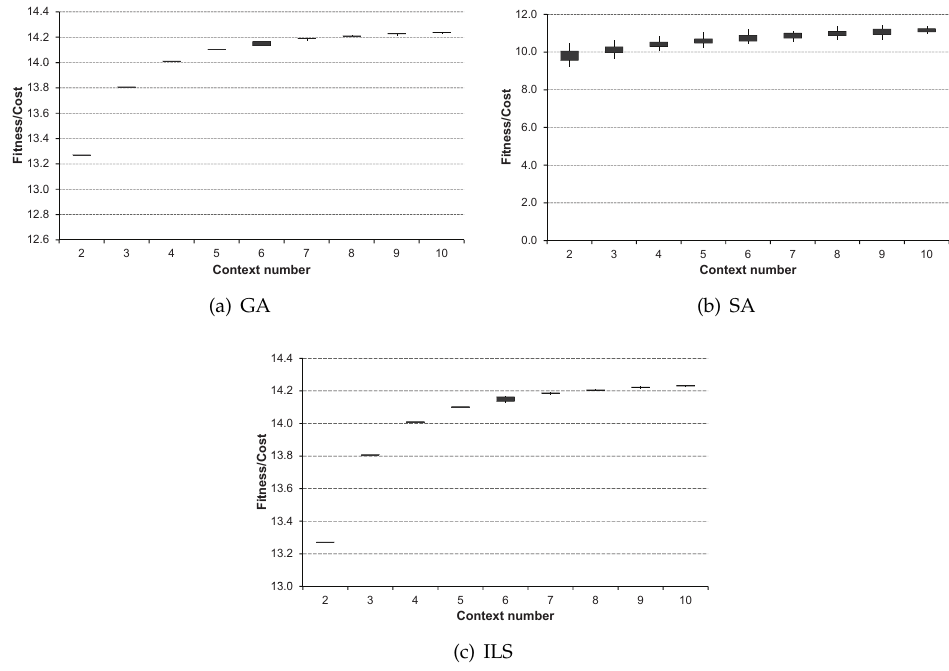
Figure 4. Fitness/cost dispersion vs. Context number applied to HL subband for neighborhood 5AR. ( a ) For GA algorithm. ( b ) For SA algorithm. ( c ) For ILS